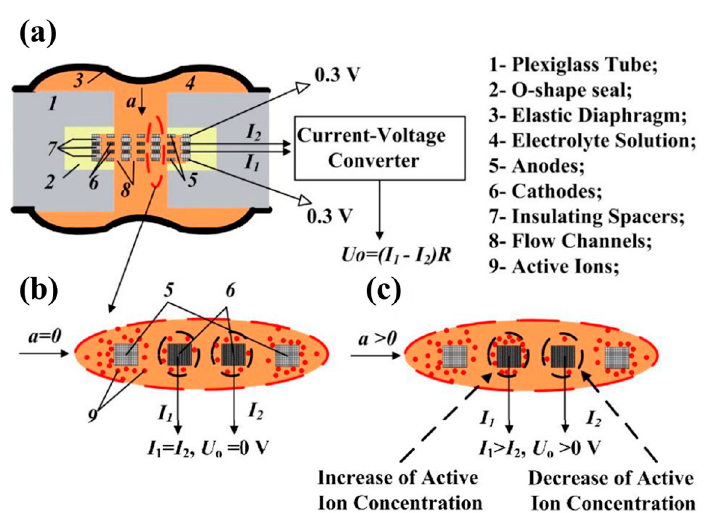
Figure 21. Schematic diagrams of an electrochemical accelerometer developed by Deng et al . at the Chinese Academy of Sciences [122]: ( a ) device; ( b ) with no acceleration input, no output voltage signal is generated as active ion concentrations surrounding both cathodes are equal; ( c ) under acceleration, a voltage output is generated as ion concentration around one cathode increases while it decreases at the other electrode.